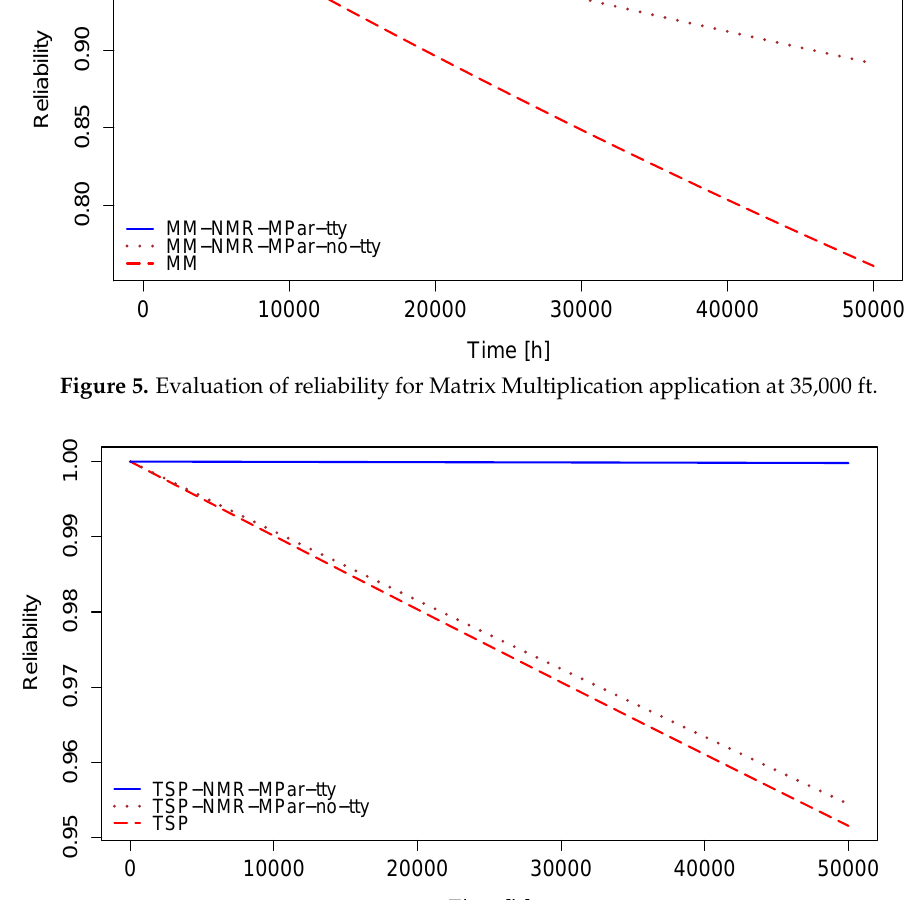
Figure 6. Evaluation of reliability for Traveling Salesman Problem application at 35,000 ft.